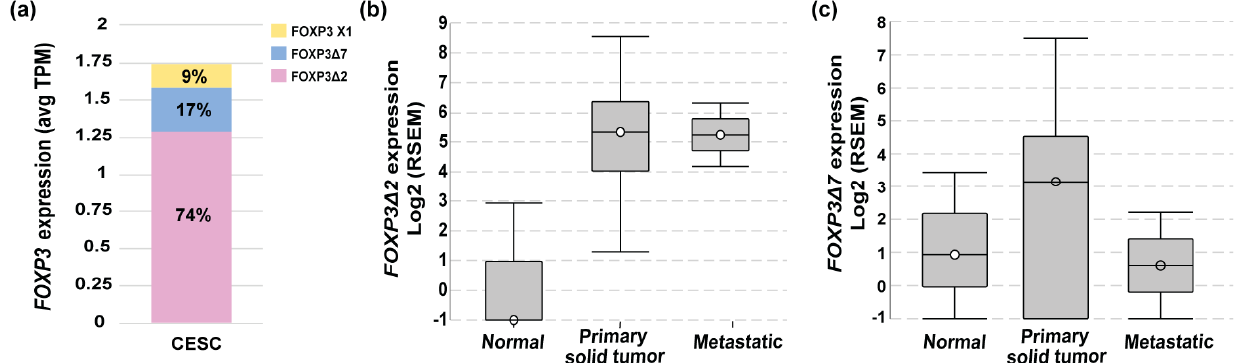
Figure 2. FOXP3 variant levels in cervical cancer. ( a ) FOXP3 expression levels and variant frequencies in transcripts per million (TPM) from TCGA-CESC data ( n = 305); ( b ) FOXP3 ∆ 2 expression abundance in RNA Seq by expectation-maximization (RSEM) in normal ( n = 1 of 3), primary solid tumor ( n = 273 of 304) and metastatic ( n = 2 of 2); TCGA-CESC, n = 309; ( c ) FOXP3 Δ 7 expression abundance in RNA Seq by expectation-maximization (RSEM) in normal ( n = 2 of 3), primary ( n = 222 of 304), and metastatic solid tumors ( n = 1 of 2); TCGA-CESC n = 309.